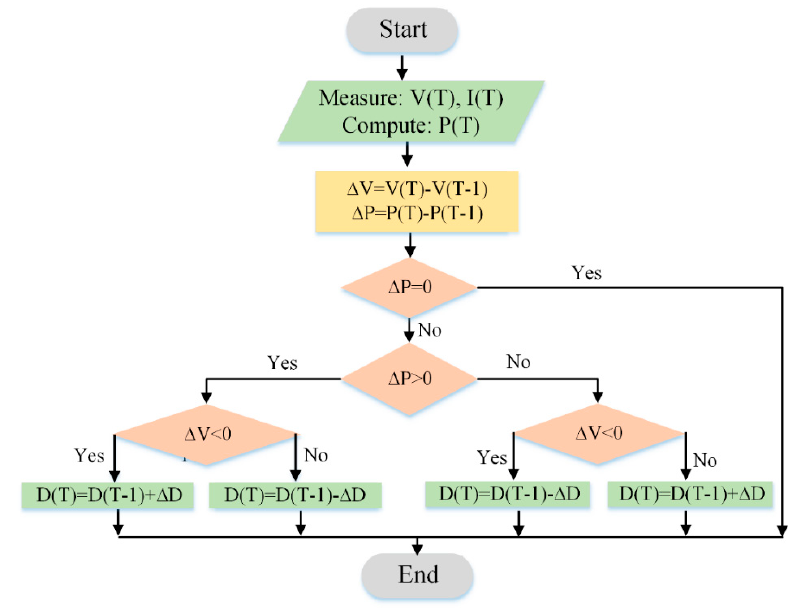
Figure 4. MPPT flowchart for the P&O algorithm. Table 1. Perturbation summary for the P&O algorithm.